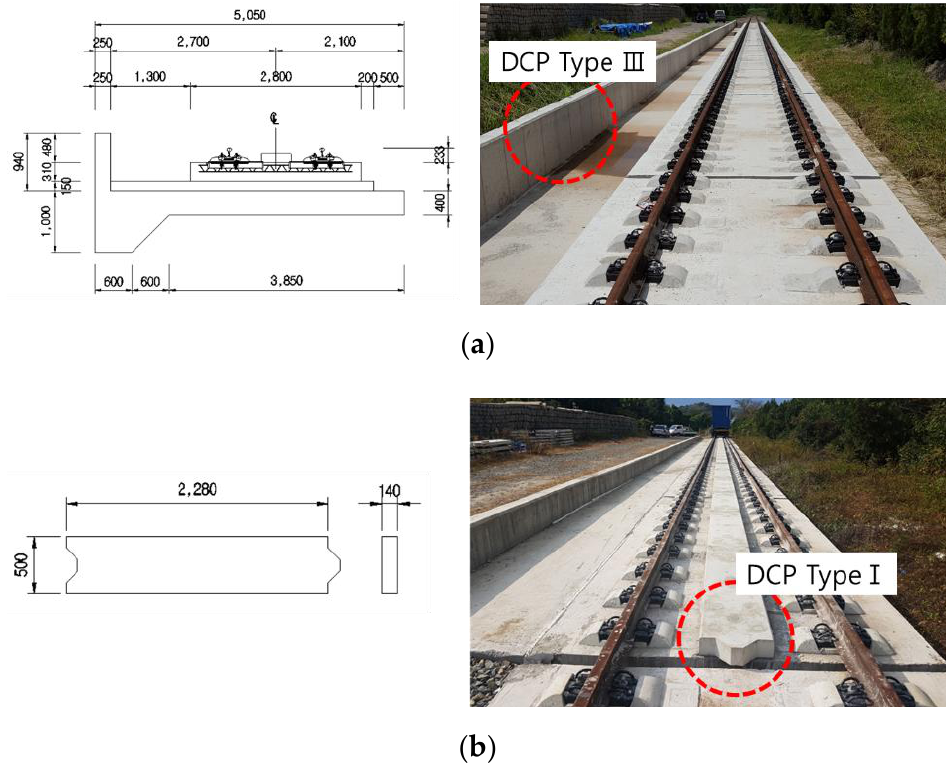
Figure 4. Railway track and DCPs in the test region: ( a ) Rheda 2000 concrete track and ( b ) concrete track with DCP type I.